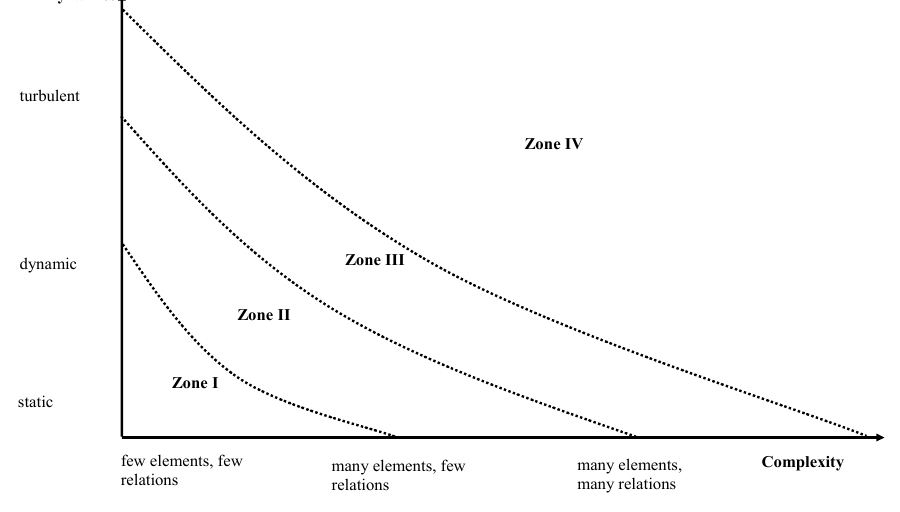
Figure 3. Zones of Dynaxity. Source own, based on